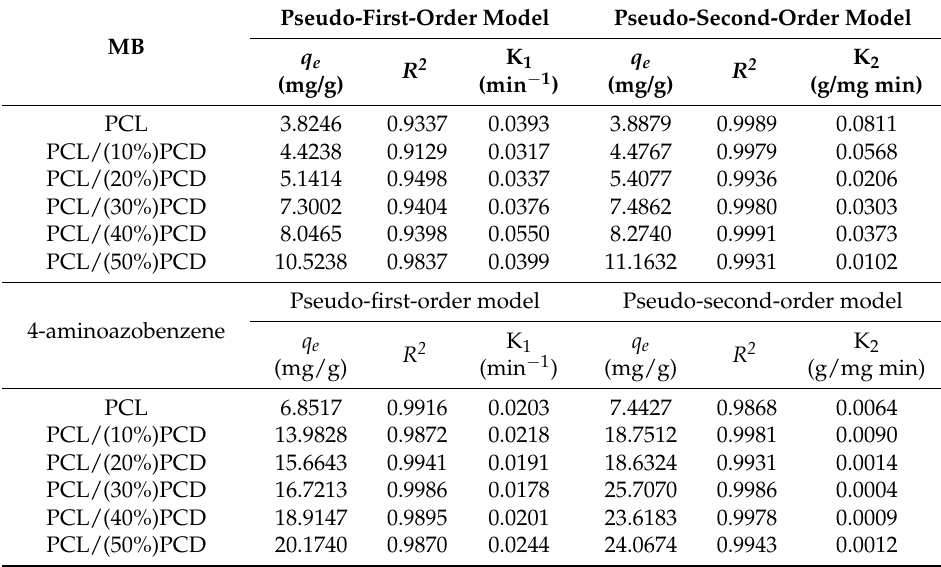
Figure 7. Kinetic adsorption of MB ( a , b ) and 4-aminoazobenzene ( c , d ). Table 3. The fitting results achieved for kinetic adsorption data using the pseudo-first-order model and pseudo-second-order model equation.